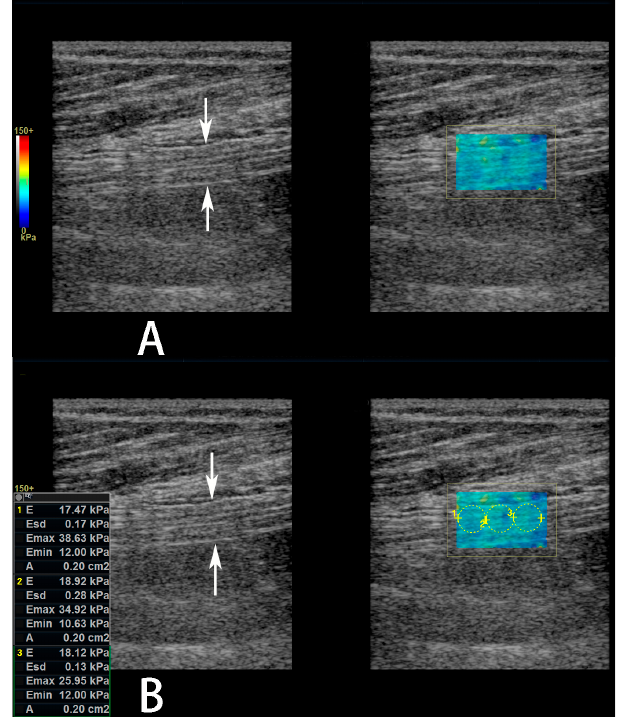
Figure 2. Measurement of sciatic nerve shear wave elastography (SWE) stiffness value. ( A , B ) Gray scale images ( left panel) of the sciatic nerve and its affiliated color-coded SWE images ( right panel) in a 61-year-old female diabetic patient with diabetic peripheral neuropathy (DPN). In the left panel, the sciatic nerve is shown between arrows. In the right panel, a color-coded box is superimposed on the image to indicate the sciatic nerve. ( B ) In the right panel, three non-overlapping circular regions of interest have been superimposed on the 2-D shear elasticity map that covered as much of the sciatic nerve as possible. The average SWE stiffness values within each region of interest (ROI) has been automatically calculated and shown on the screen. Additionally, the US examinations of arteries in the lower limbs were performed within one week before or after the sciatic nerve US examination according to the refer- ence criteria [16]. The diagnosis of severe artery stenosis (70–99% stenosis) in the lower limbs was defined as flow velocity ratios between the stenosis site and proximal corre- sponding artery greater than or equal to 4 [16,17]. The diagnosis of a full occlusive artery in the lower limbs was defined as detecting no flow signal in the corresponding artery by duplex Doppler.